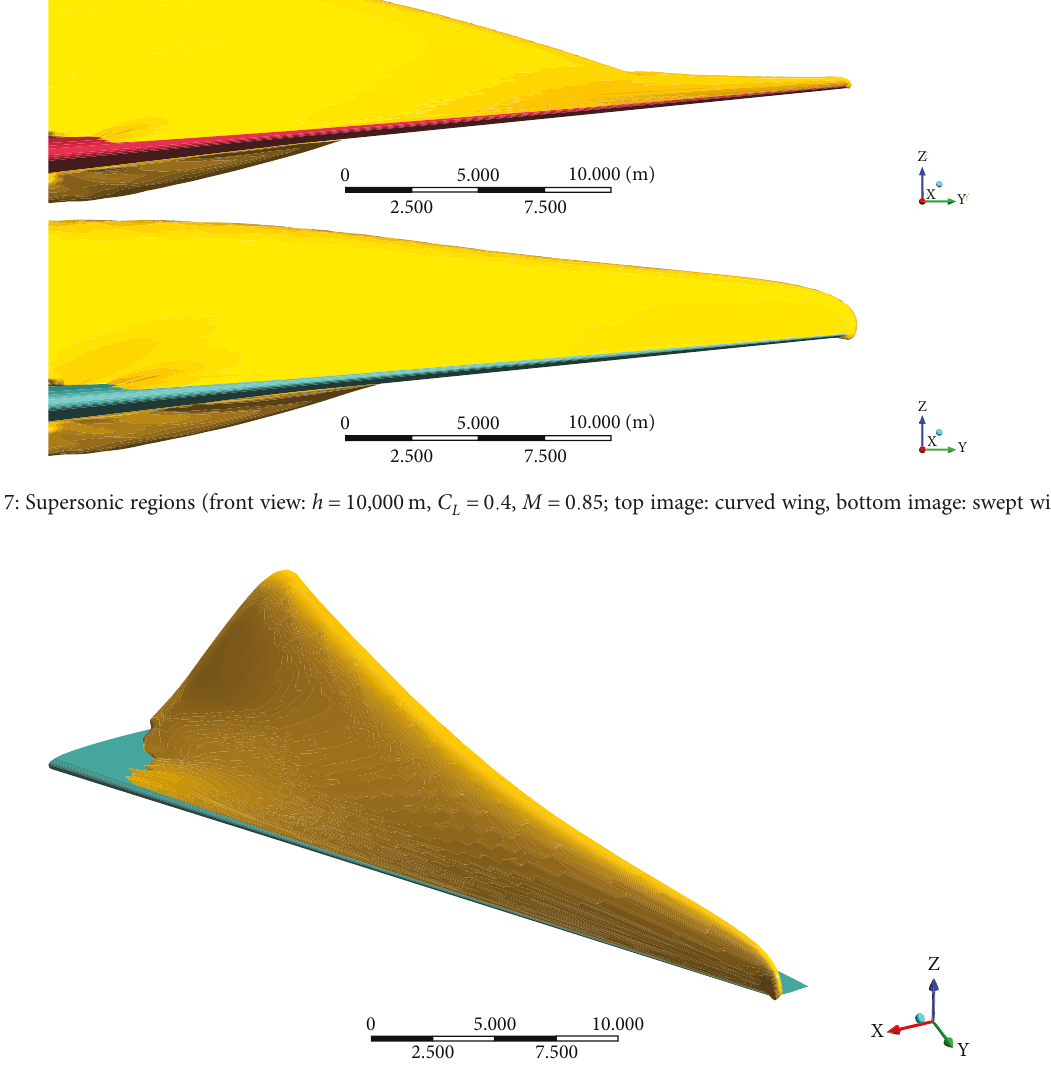
Figure 8: Supersonic region (swept wing: isoview front).